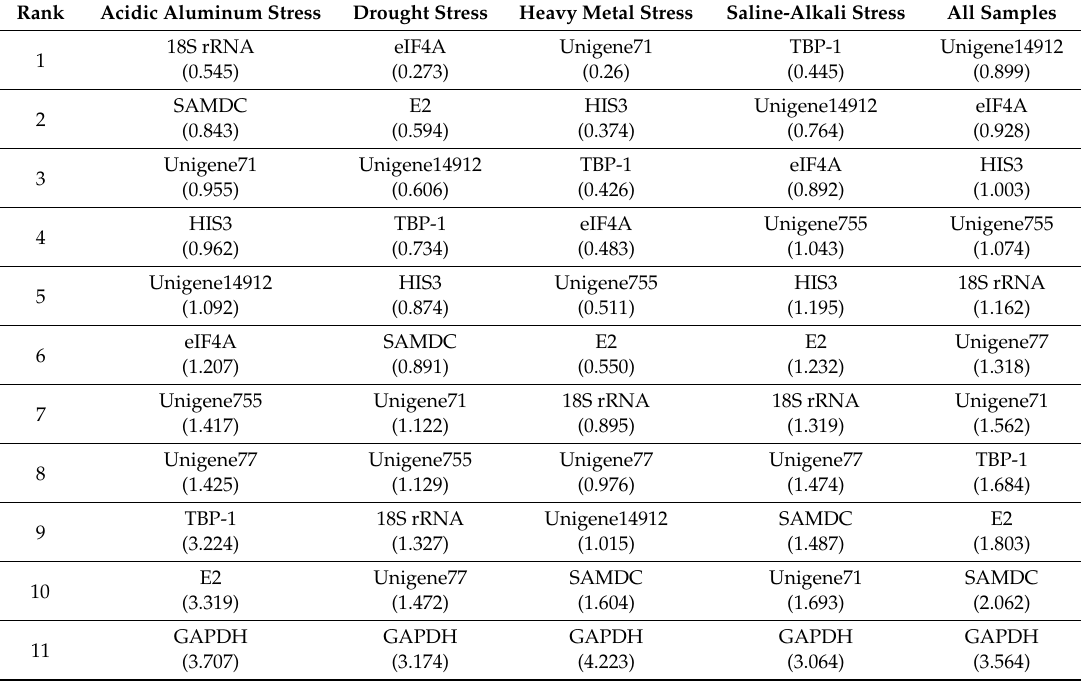
Table 2. Expression stability values for annual ryegrass candidate reference genes calculated using